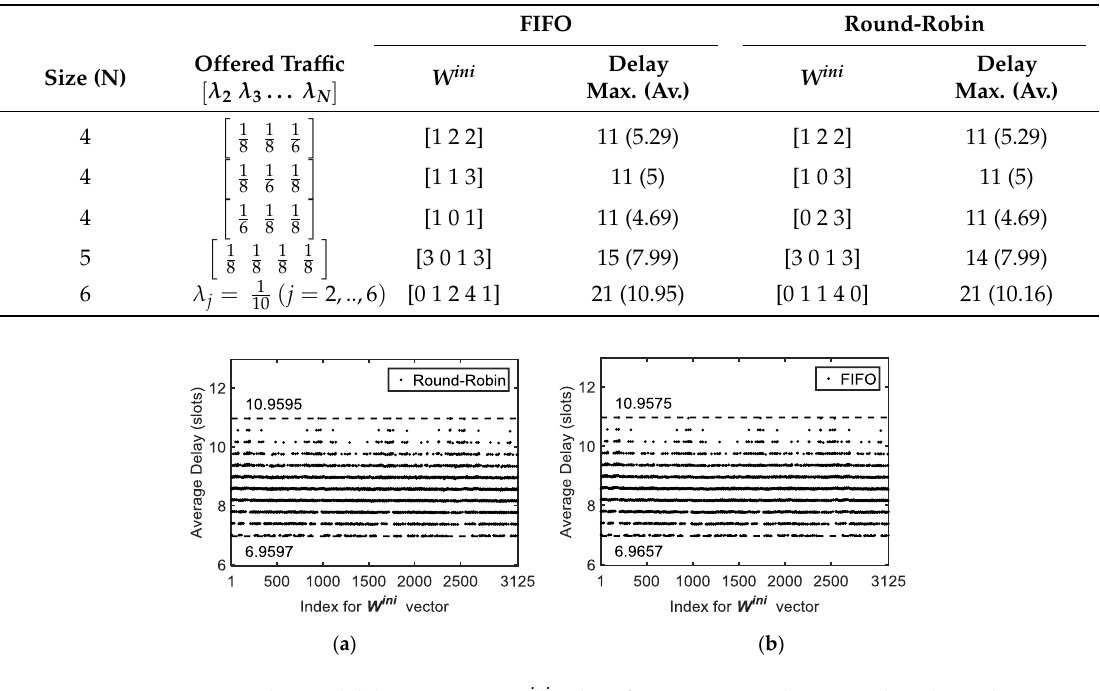
Figure 11. Average end-to-end delay sweeping 𝑾 𝒊𝒏𝒊 values for an 𝑁 = 6 nodes network and simulation time of 1000 slots. The two service policies considered (Round-Robin ( a ) and FIFO ( b )) have similar values. The discretization in the y -axis is because the transmissions are allowed by the scheduler only at the beginning of a time slot.